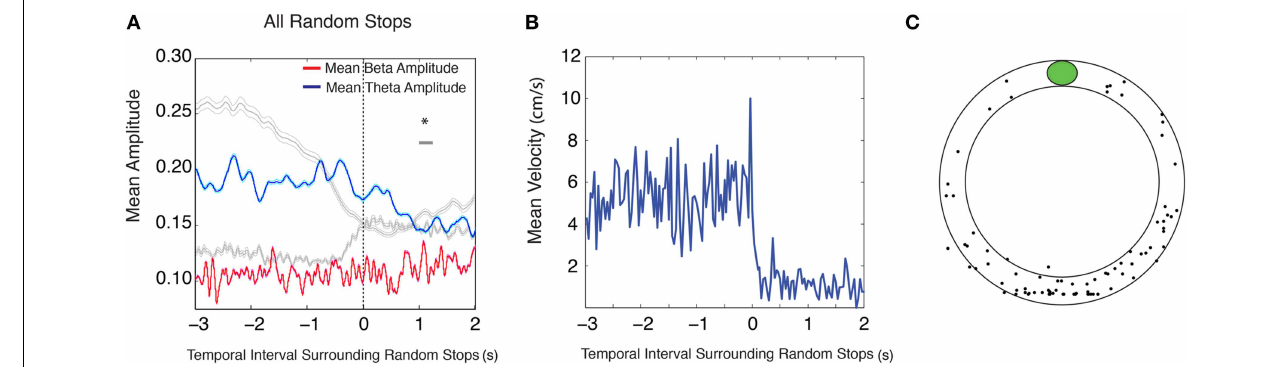
lower gray bar indicates 250ms bins with significant increases in beta amplitude ( red ). Error bars indicate standard error for theta ( cyan ) and beta ( magenta ) means. (B) Mean velocity during intervals surrounding random stops. (C) Distribution of random stops with respect to reward location. The plot does not depict the physical location of a stop on the circular track, but rather the location of a stop with respect to a given condition reward location; significant via Tukey’s HSD, * p < 0 . 05 .